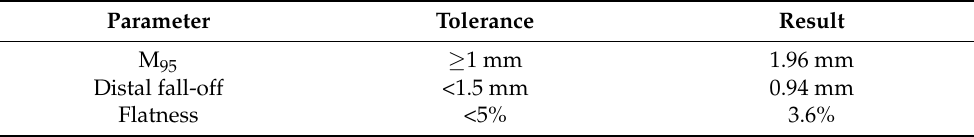
Table 4. Beam quality parameter tolerances and obtained results of the final depth-dose profile. The calculation of quality parameters is defined in detail in [31]. Here, the distal fall-off was defined as the 80–20% Penumbra.